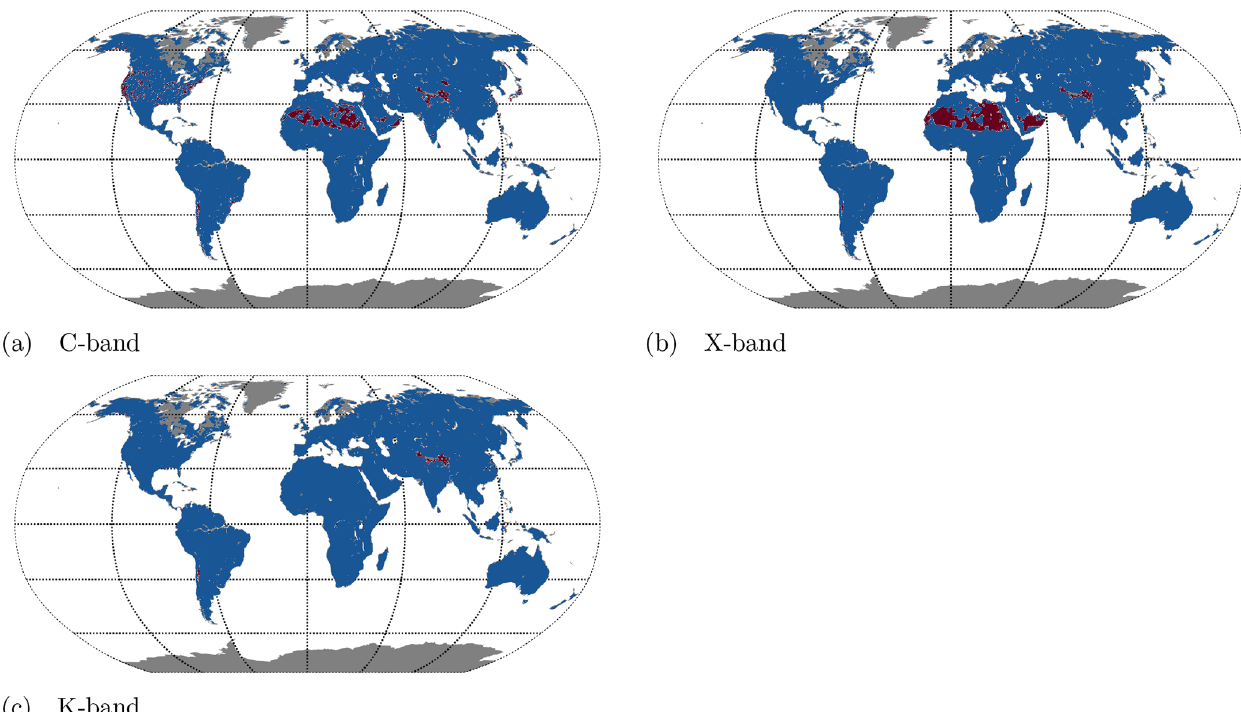
Figure 9. Data loss during CDF matching of different WindSat bands. CDF matching failed for the red grid points and therefore the data of WindSat at that location are dropped. Very similar looking maps exist for the other sensors in Figs. S7–S9.